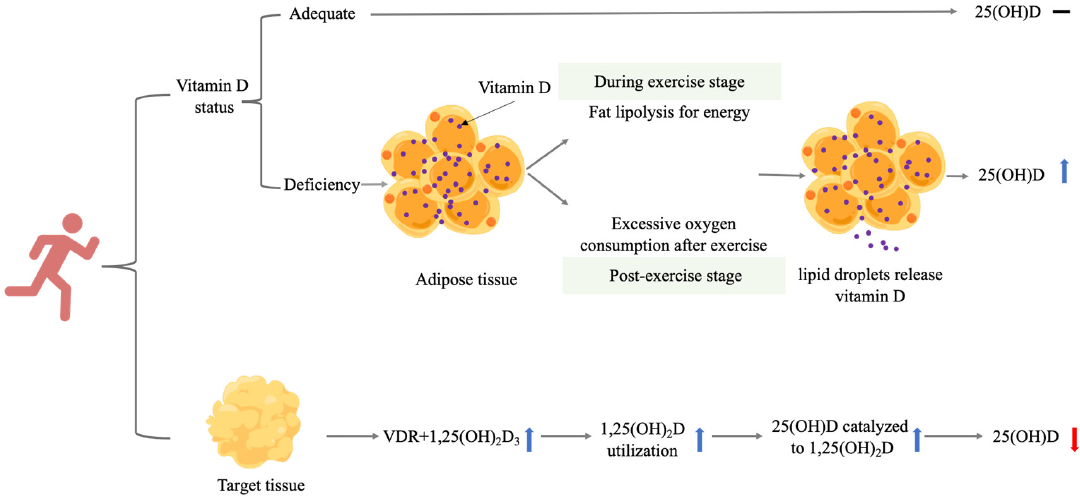
Figure 1. Possible mechanisms of the effect of endurance training on serum 25(OH)D. Vitamin D indicates serum vitamin D metabolites; − indicates no significant change; ↑ indicates significant increase; and ↓ indicates significantly reduction. Vitamin D status: 25(OH)D ≥ 20 ng/mL or 50 nmol/L; vitamin D deficiency: 25(OH)D < 20 ng/mL or 50 nmol/L. Abbreviations: VDR, vitamin D receptor.